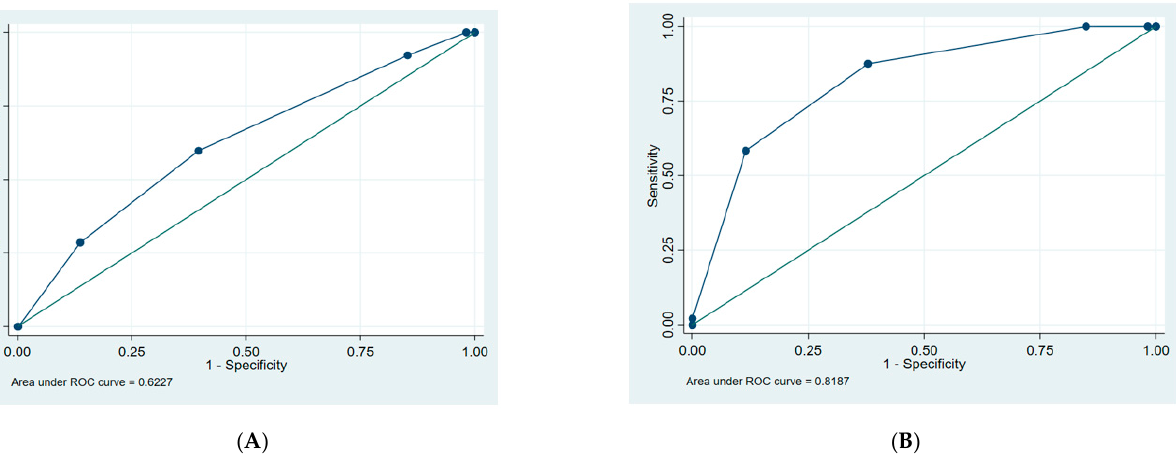
Figure 2. ( A ) Receiver operating curve: Clinical frailty scale and poor outcome. ( B ) Receiver operating curve: Clinical frailty scale and permanent nursing home admission.